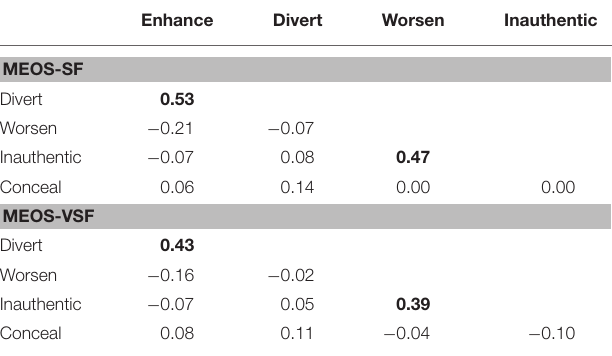
TABLE 4 | Factor score bivariate correlations for the MEOS-SF and